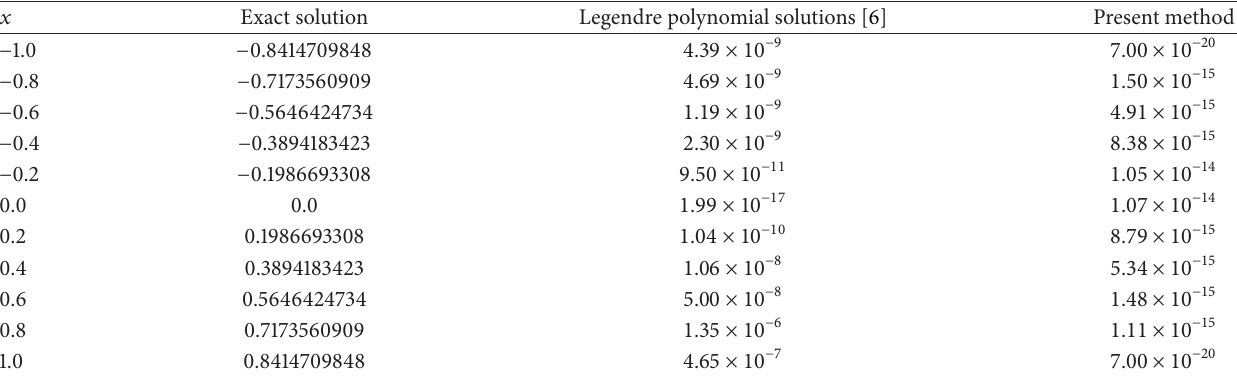
Table 9: A comparison of absolute errors between Lps and present method.